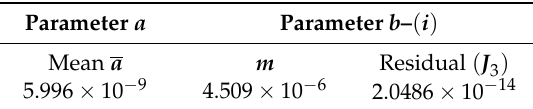
Table 4. Parameter (cid:1854) estimation . Table 4. Parameter b